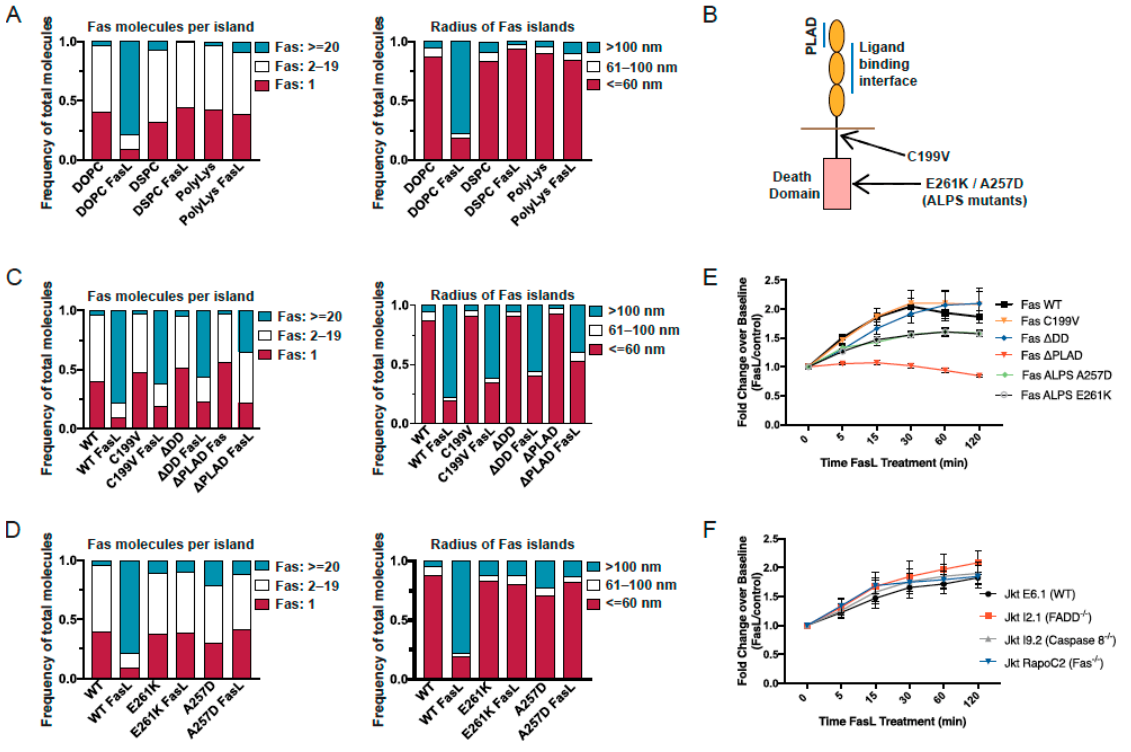
Figure 2. Contributions of structural domains of Fas to nanoscale receptor clustering. ( A ) Spatial distribution of Fas receptors was quantified following interaction of Jurkat cells with different FasL- containing substrates. FasL was either incorporated into fluid DOPC-based supported lipid bilayers, gel-like DSPC-based supported lipid bilayers, or immobilized onto polylysine-coated coverslips. Cluster parameters were evaluated with or without stimulation with FasL. ( Left panel) Plot of distribution of percentage of Fas receptors in protein islands containing indicated number of proteins. ( Right panel) Distribution of percentage of proteins residing in protein islands of indicated size (radius in nm). ( B ) Schematic of Fas receptor showing the location of preligand assembly domain (PLAD), the palmitoylation site CysC199, the death domain, and the ALPS mutations. ( C , D ) Cluster parameters of protein islands of wild-type Fas or indicated Fas receptor mutants (C: structural mutants, D: ALPS mutants) with or without interactions with FasL. Plots of distribution of percentage of proteins in protein islands of indicated protein occupancy ( left panel, C , D ), or within protein islands of indicated size ( right panel, C , D ). ( E ) Fas-deficient Jurkat cells (RapoC2) were cotransfected with homotypic pairs of indicated receptors, each tagged with either mCerulean3 or mVenus. 24 h post-transfection, cells were treated with FasL-LZ, and FRET between the pairs of Fas molecules was measured at the indicated timepoints. Fold change was calculated as the change in FRET intensity over similarly transfected, but untreated, cells. A minimum of n = 4 was performed for each experimental condition. ( F ) Wild-type Fas receptors tagged with either mCerulean3 or mVenus were cotransfected into wild-type Fas-sufficient Jurkat cells or mutant Jurkat cells deficient for Fas (RapoC2), FADD (I2.1), or caspase-8 (I9.2). Cells were stimulated with FasL-LZ, as in ( E ), and assessed for Fas–Fas FRET via flow cytometry on the Cerulean3 + Venus + viable population. Fold change was calculated as in ( E ). A minimum n = 3 was performed for each experimental